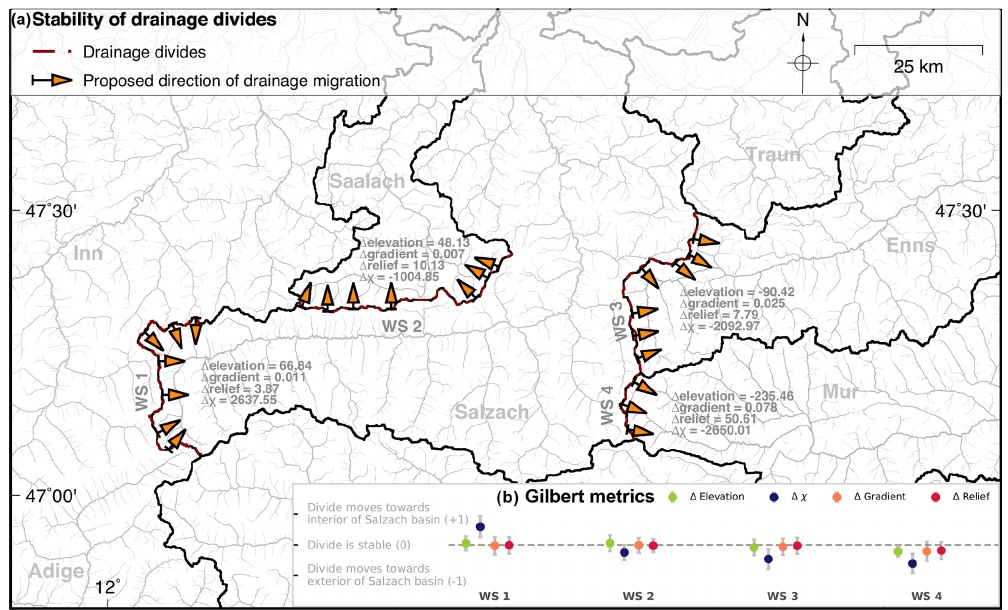
Figure 6. Proposed direction of drainage migration of the main drainage divides in the study area. (a) The major drainage basins are annotated. Orange arrows indicate the proposed migration direction of divides based on χ . Gilbert metrics for each investigated catchment are shown. Positive (cid:49) elevation and (cid:49)χ values as well as negative (cid:49) relief and (cid:49) gradient indicate migration towards the Salzach drainage basin. (b) Normalized (cid:49) plot of Gilbert metrics. Negative values of (cid:49) relief and (cid:49) gradient are standardized to positive values such that all positive values indicate a migration towards the Salzach basin. The error bar and filled circles indicate 1 standard deviation and mean values,